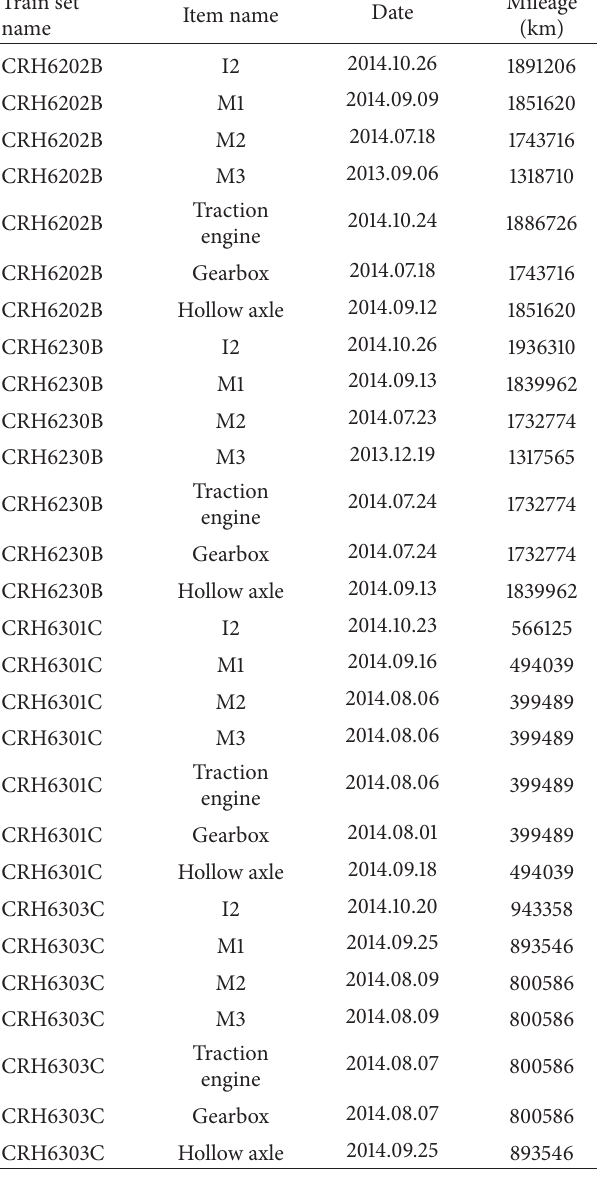
Table 4: Maintenance records of motor train sets. Train